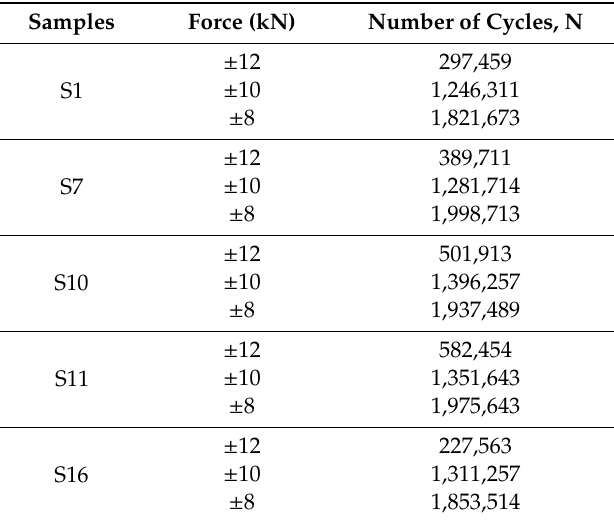
Table 11. Results for fatigue